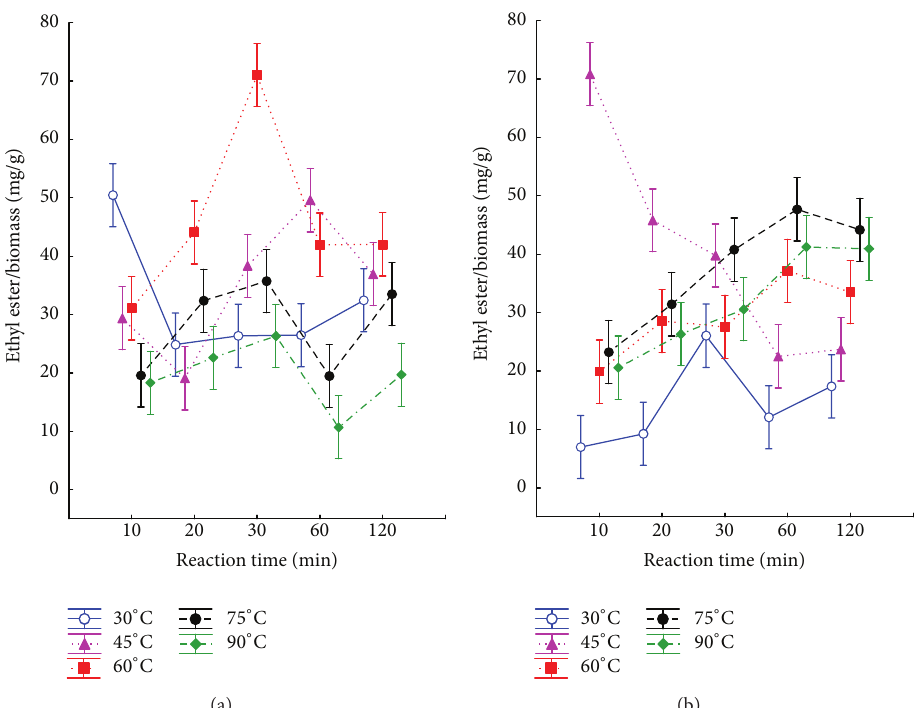
Figure 2: Mass of ethyl ester obtained in the in situ reaction with chloroform (a) and hexane